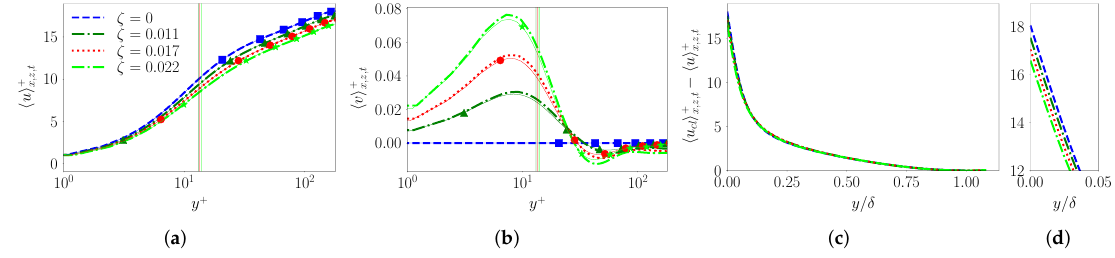
Figure 6. Inner scaled mean ( a ) streamwise velocity, ( b ) vertical velocity, and ( c ) defect velocity computed using local coordinate-based average; zoomed version near the surface ( d ). The thick lines represent averaging at constant y local ,1 and the thin lines with markers represent averaging at scaled y local ,2 . Three vertical straight lines correspond to the different a + for ζ > 0 (see Table